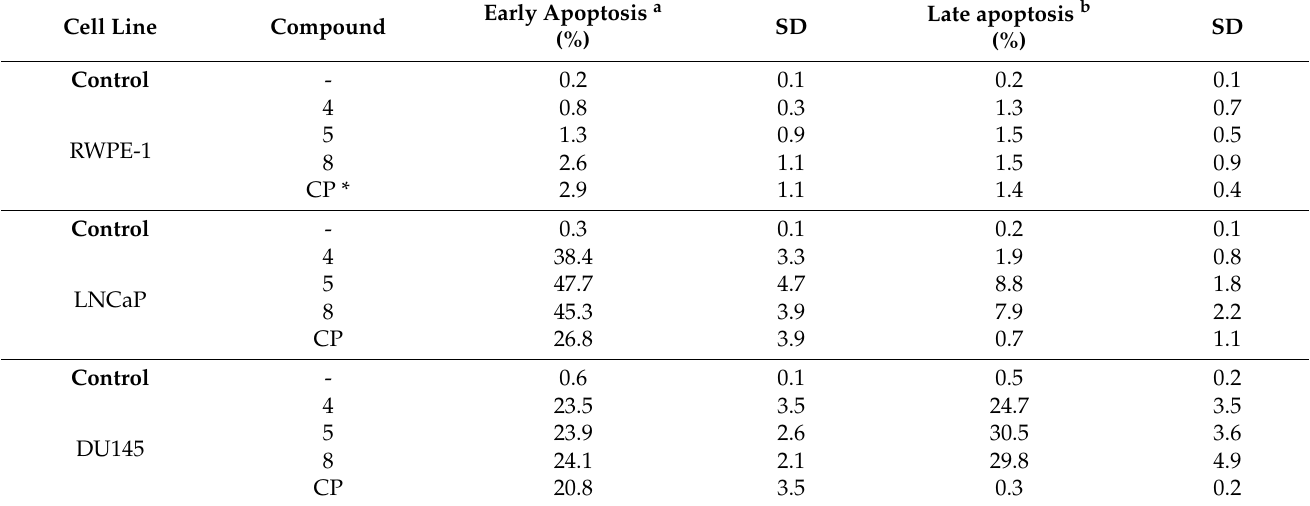
Table 4. The effect of new ciprofloxacin derivatives 4 , 5 , 8 and * free ciprofloxacin on early